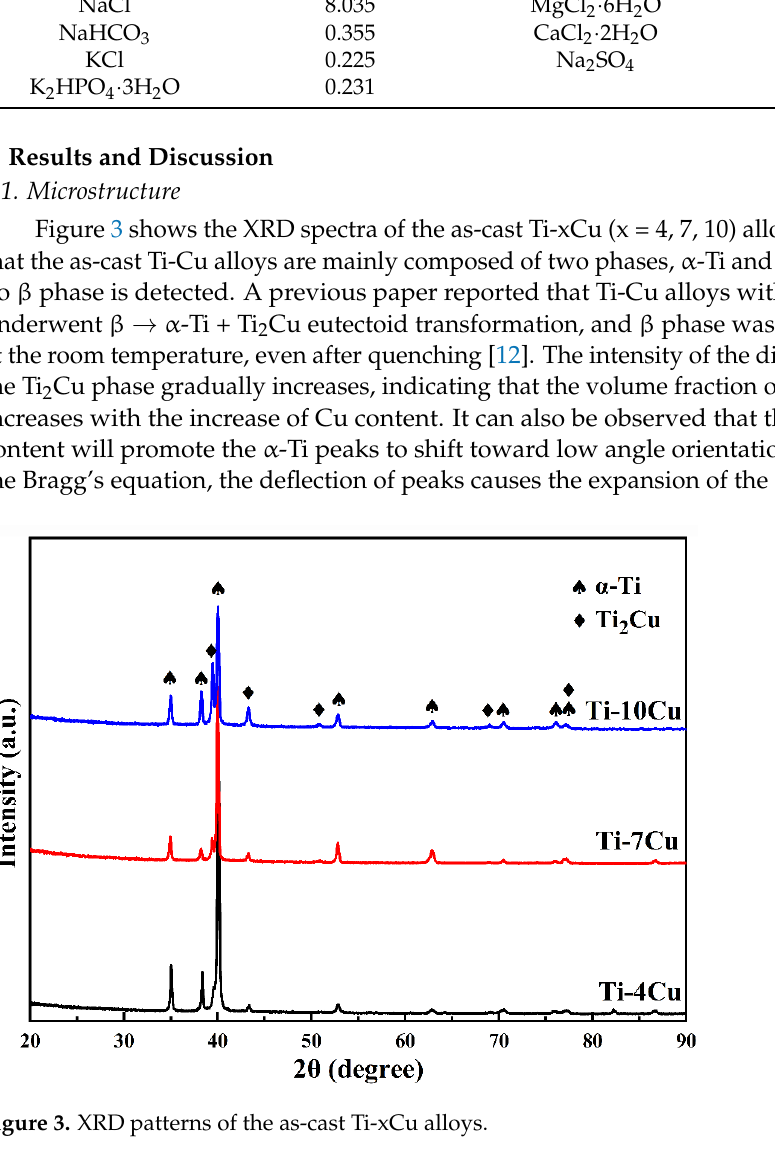
Table 1. Chemical composition of the simulated body fluid (SBF) solution (g/L) [16]. Composition Concentration Composition Concentration